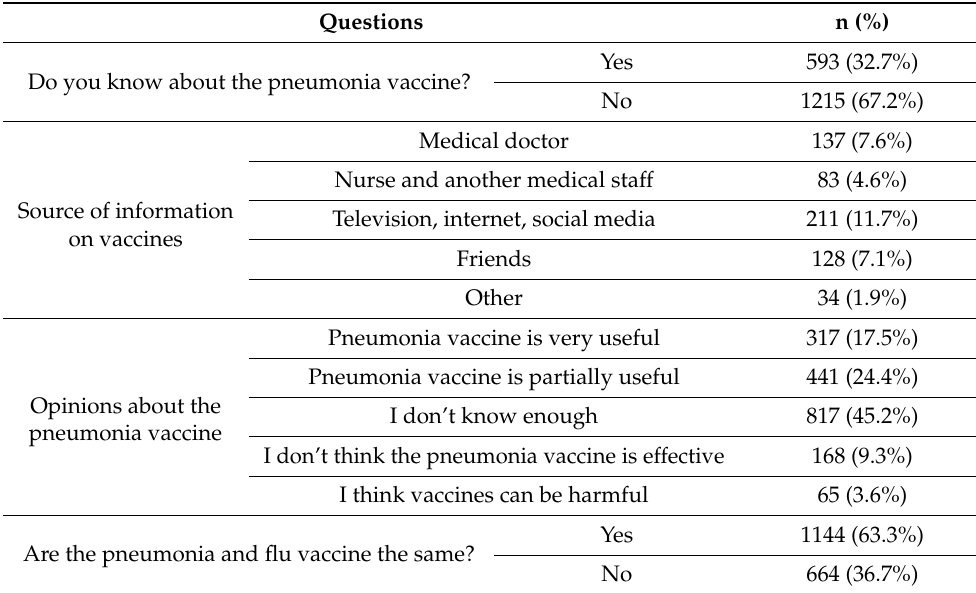
Table 2. Knowledge and attitudes about